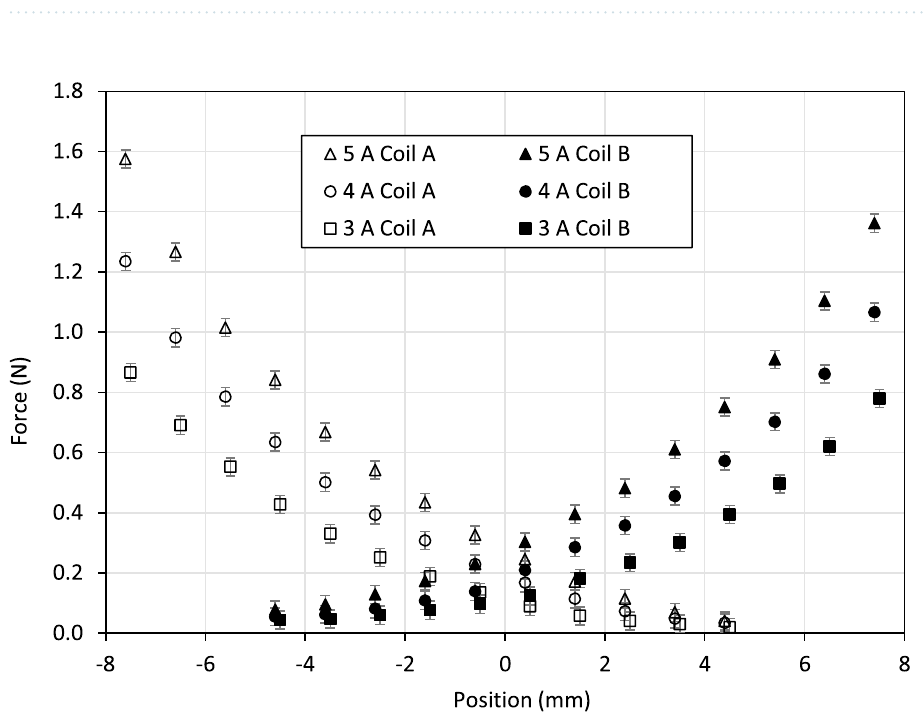
Figure 11. Measured actuation forces for different current values and piston positions. Results are shown for static (blocked) operation with current supplied to a single coil at each end of the